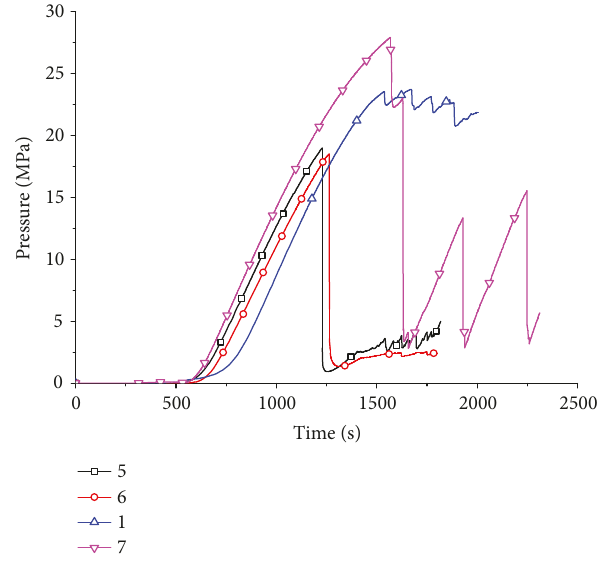
Figure 17: Pressure curves in the core fracturing process.